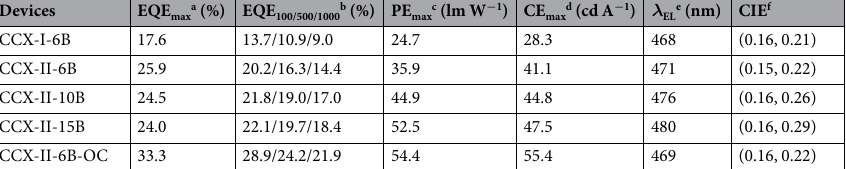
Table 2. OLED performance of devices based on CCX-I and CCX-II. a Maximum η EQE . b η EQE at 100, 500, 1000 cd m − 2 . c Maximum power efficiency. d Maximum current efficiency. e Peak wavelength of EL spectra at 1000 cd m − 2 . f CIE coordinates at 1000 cd m − 2